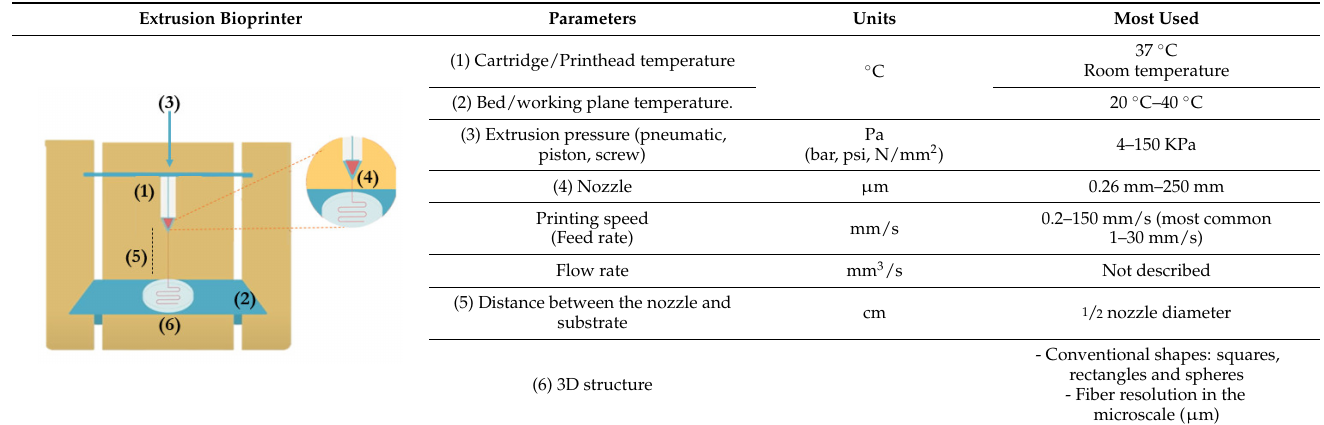
Table 3. Printing conditions for protein-based bioinks